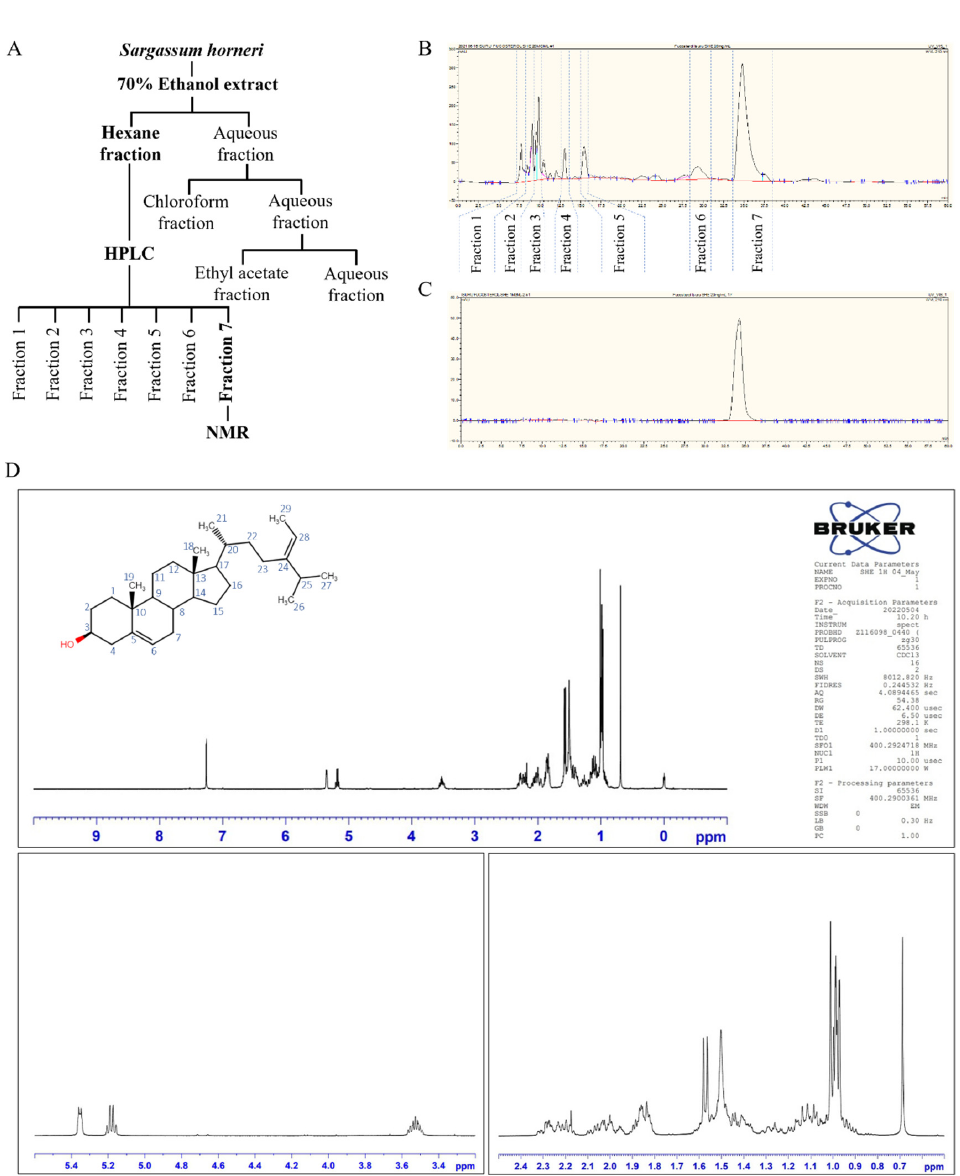
Figure 1. ( A ) Flow diagram representing the extraction and fractionation of S. horneri 70% ethanol extract. ( B ) HPLC chromatogram of hexane fraction. ( C ) HPLC chromatogram of prominent peak collected from hexane fraction and, ( D) pure compound was characterized using 1 H NMR analysis. All experiments were performed in triplicate ( n = 3) to determine repeatability. Table 2. Numerical values of spectra of the 1 H-NMR values of FST.